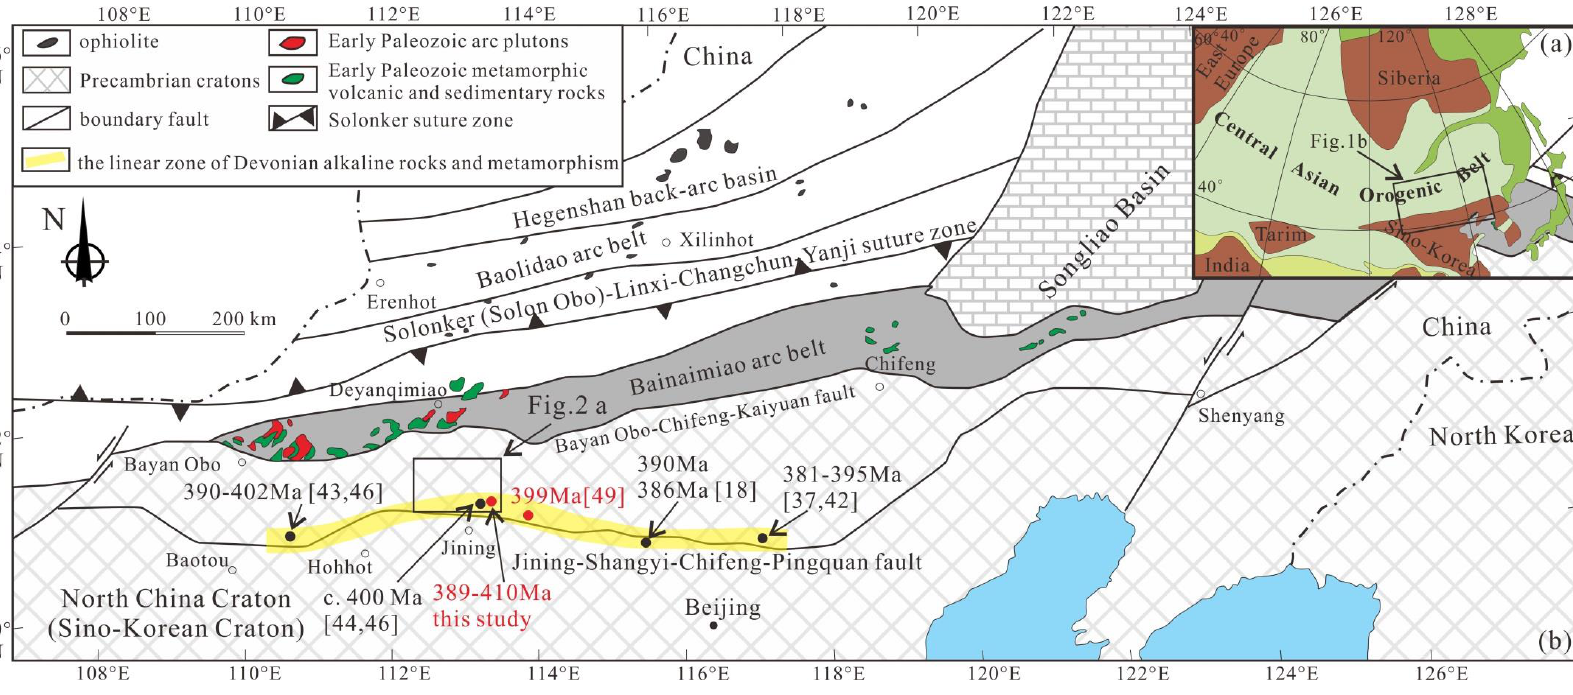
Figure 1. ( a ) Sketch geological map of Central Asian Orogenic Belt (CAOB) (modified after [3]); ( b ) the tectonic division of CAOB in central part of Inner Mongolia, China (modified after [12,46], the yellow belt is the linear zone of Devonian magmatism and metamorphism, the ages shown by black are representative zircon U-Pb ages of Devonian alkaline rocks, those shown by red are representative muscovite 40 Ar- 39 Ar ages ).